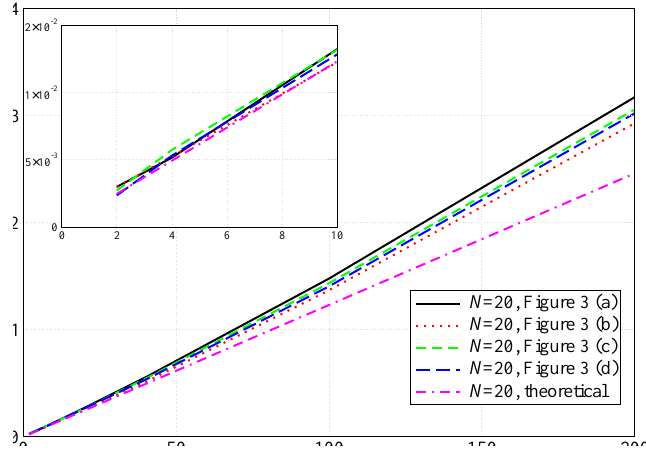
Figure 10. PER as a function of the aggregated offered traffic load Ng . Different topologies for scenarios with N = 20 nodes are considered. In all cases, the sparsity index is set to 0.87.